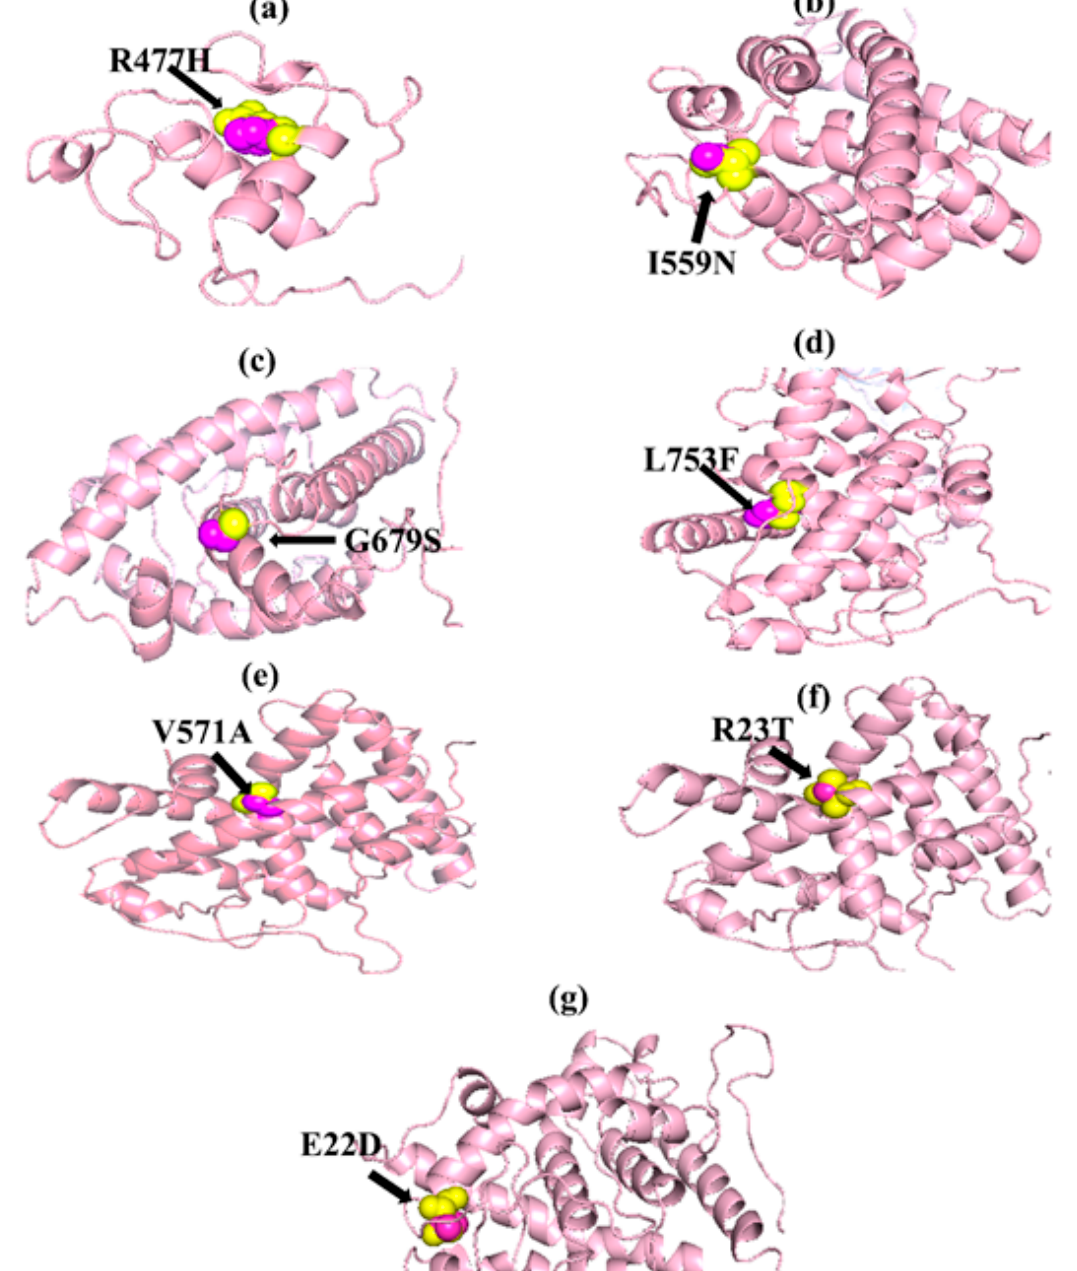
Figure 2. PyMOL was used to visualize 3D structure comparison modeling of the NR3C1 protein. ( a ) The native amino acid arginine (yellow) with the mutant amino acid histidine (purple) at position 477. ( b ) At position 559, the native amino acid isoleucine (yellow) with the mutant amino acid asparagine (purple). ( c ) A sphere-shaped native amino acid glycine (yellow) with a mutant amino acid serine (purple) at position 679. ( d ) At position 753, the native amino acid leucine (yellow) with the mutant amino acid phenylalanine (purple). ( e ) At position 571, the native amino acid valine (yellow) with the mutant amino acid alanine (purple). ( f ) At position 23, the native amino acid arginine (yellow) with the mutant amino acid threonine (purple). ( g ) At position 22, the native amino acid glutamic acid (yellow) with the mutant amino acid aspartic acid (purple).